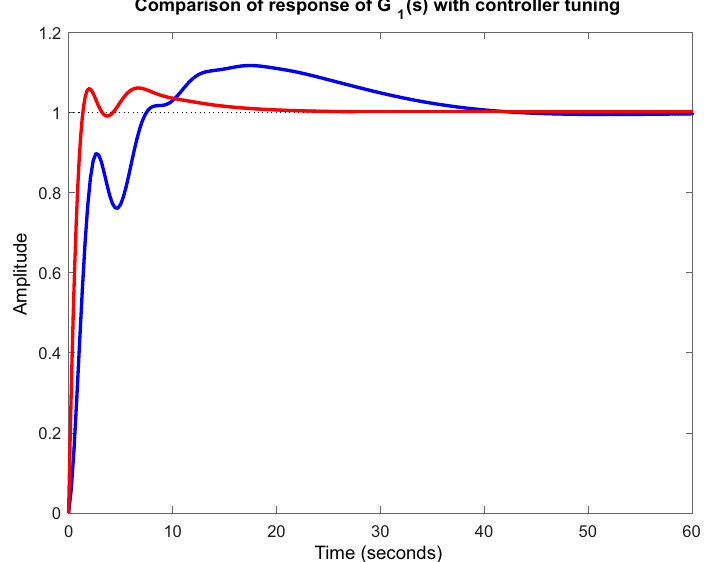
Figure 7. Comparison of response of G1(s) with both methods: proposed tuning method and PI/PID tuning method